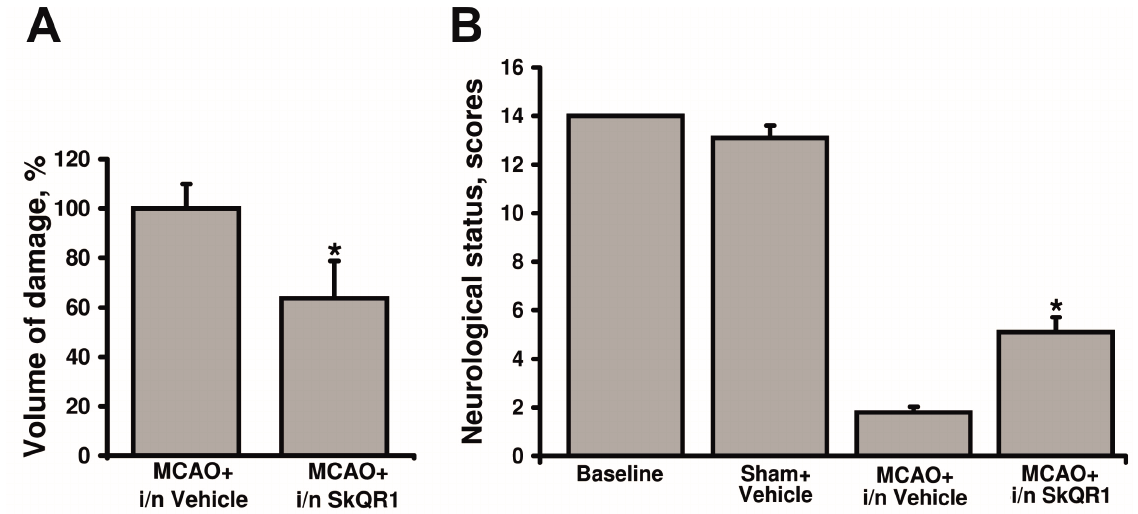
Figure 6. Neuroprotective effect of intranasal administration of SkQR1. ( A ) Infarct volume was measured in the MR T2-weighted images obtained 24 h after MCAO; ( B ) Neurological status estimated using limb-placing test. Animals were tested 24 h after MCAO. * denotes significant difference from the MCAO + i/n Vehicle vs. MCAO group i/n treated SkQR1 ( p < 0.05) (Student’s t -test for ( A ); the Mann-Whitney u -test for ( B